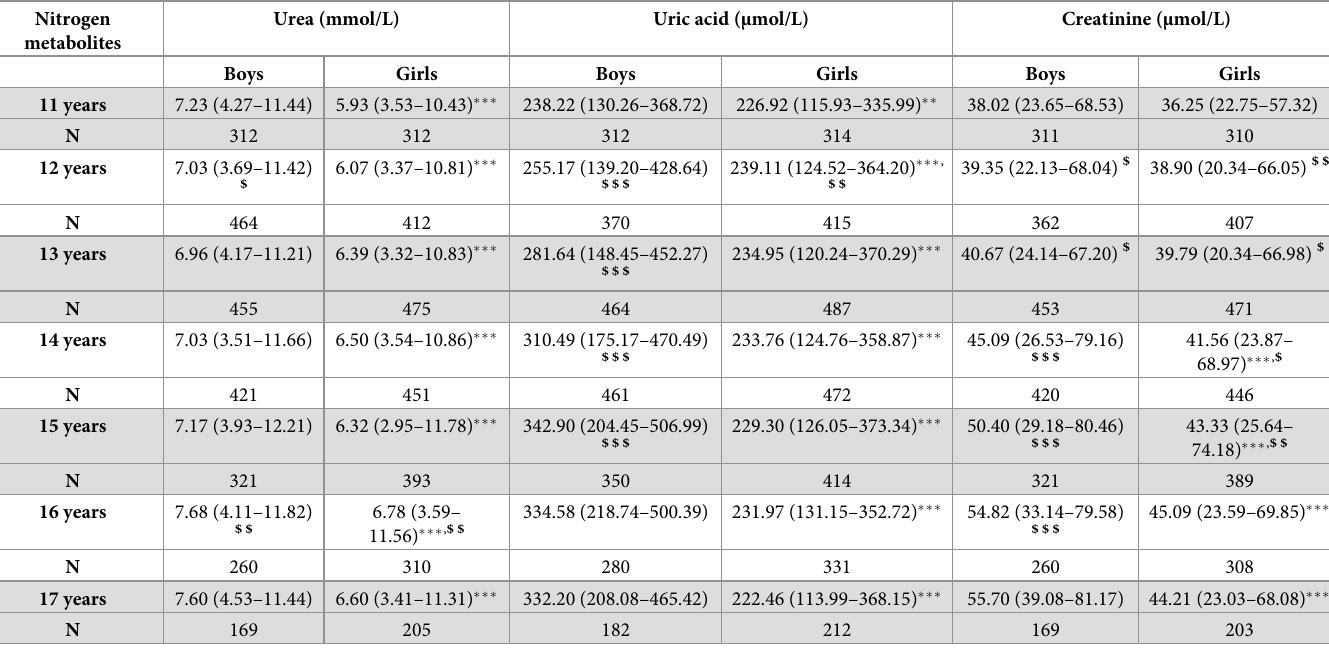
Table 4. Status of nitrogen metabolites in adolescent boys and girls with age. Nitrogen metabolites